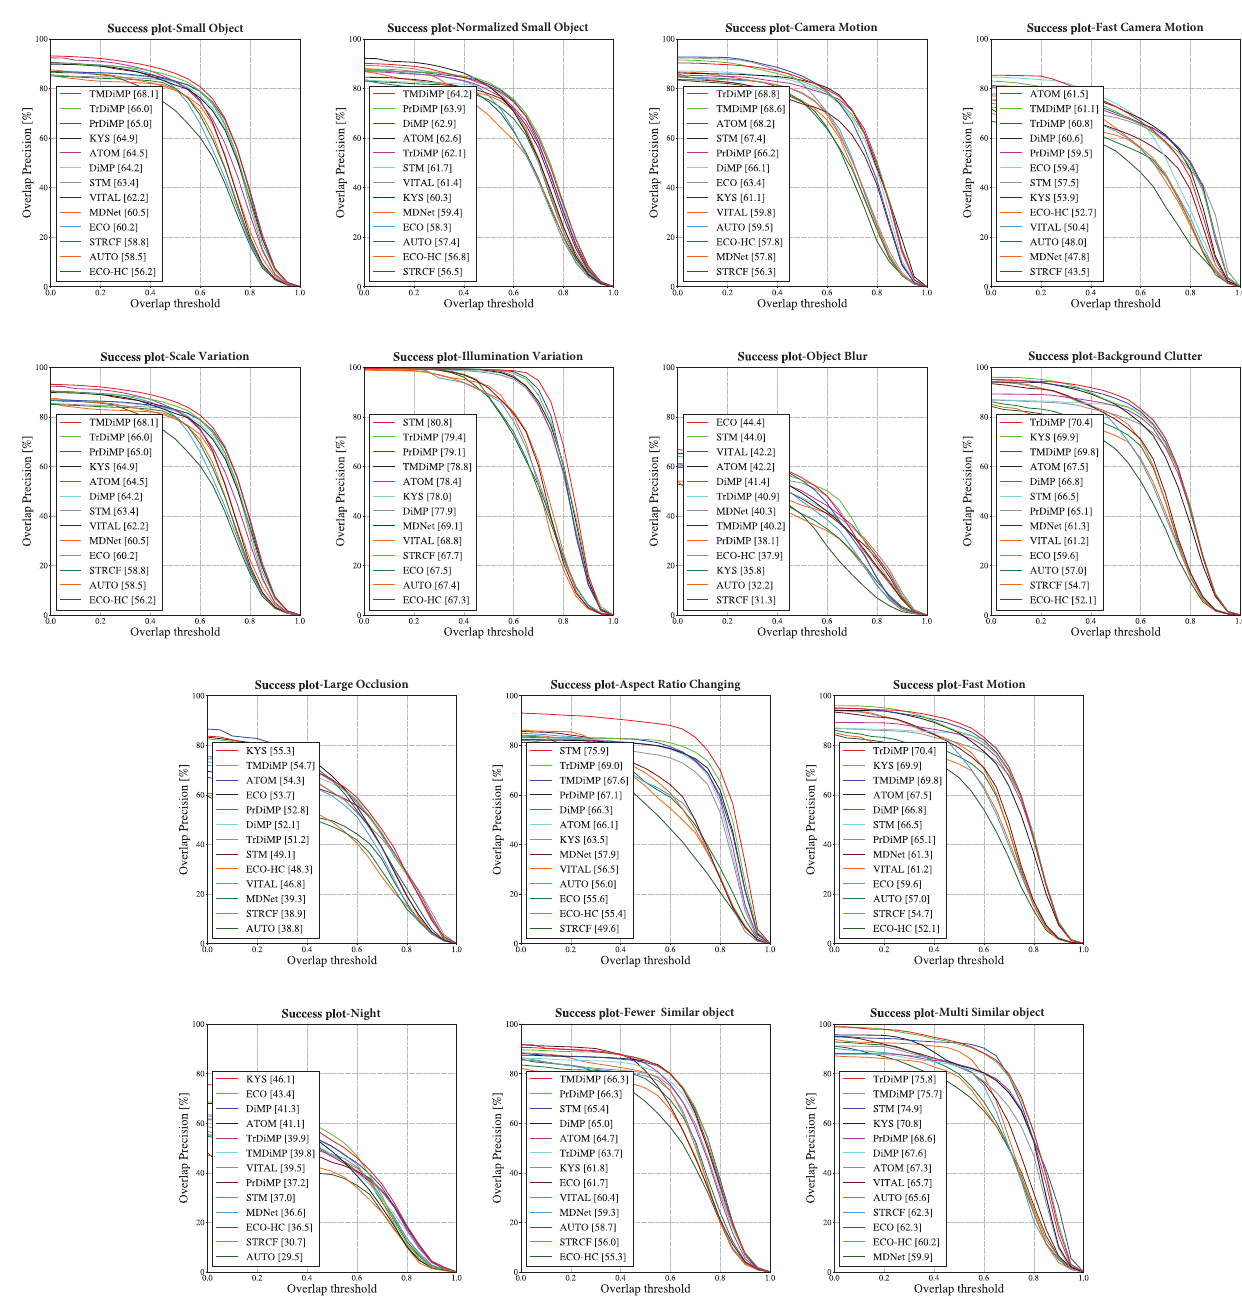
Figure 7. Success plots of different attributes on